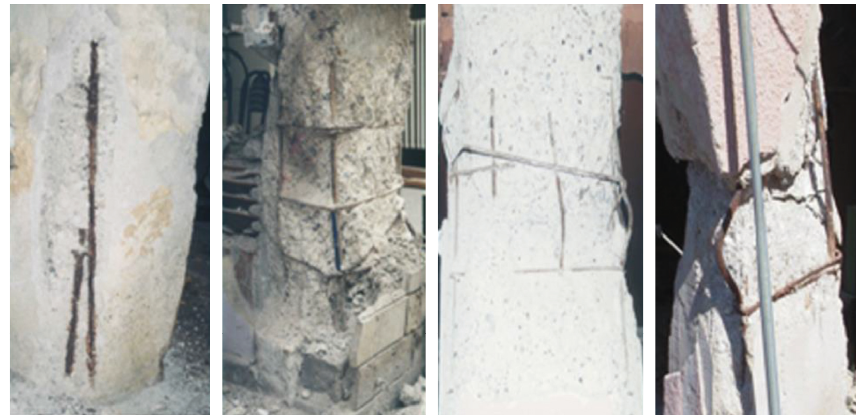
Figure 2: Corrosion of RC members damaged during the 1999 Izmit Earthquake in Turkey [7].